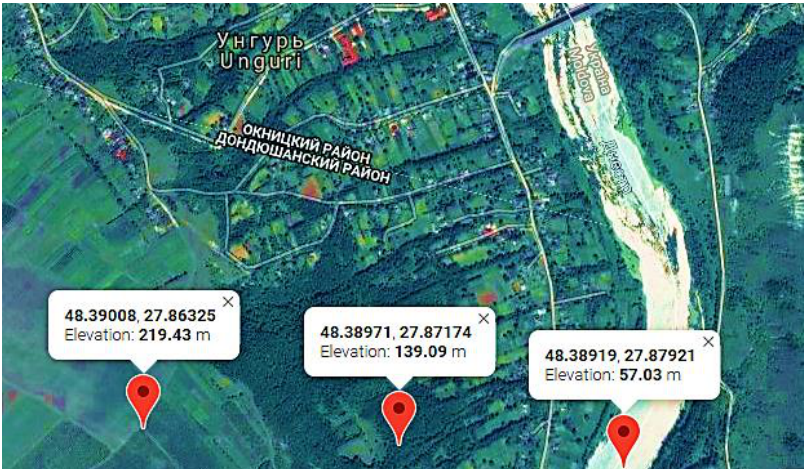
Figure 4. Location of the upper reservoir on the right bank of the Nistru river, on the hills of Unguri village, Ocnita.